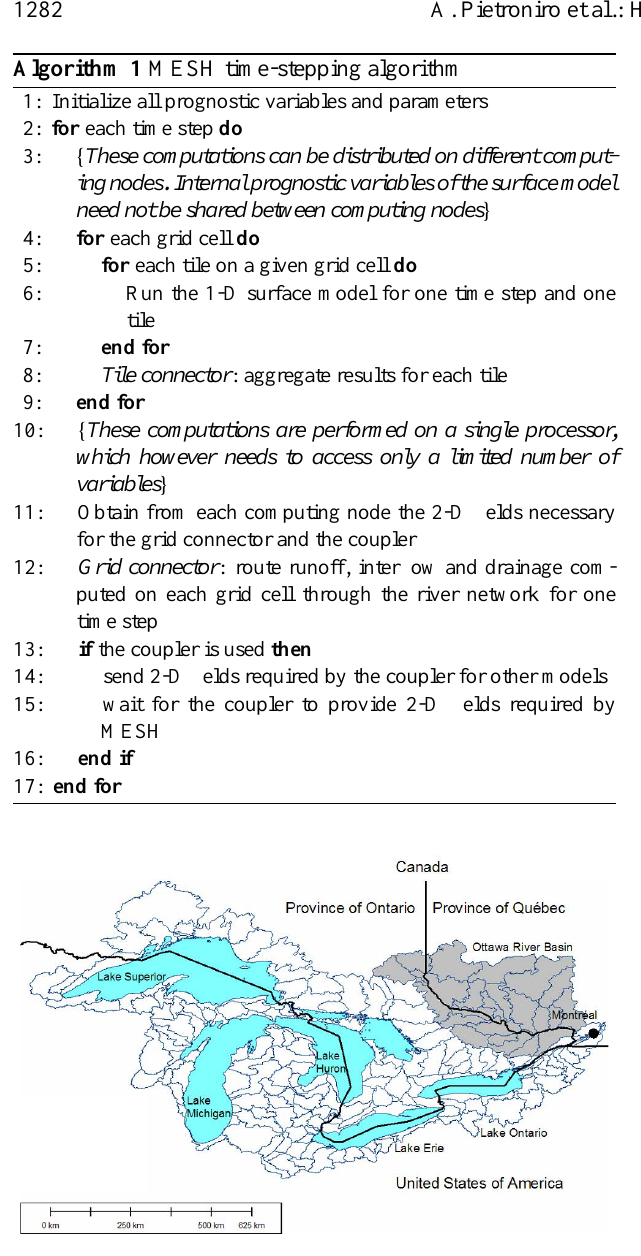
Fig. 2. The Great Lakes and St. Lawrence basins upstream of Montr´eal, with the Ottawa River basin shown in gray and the provincial and international boundaries shown in